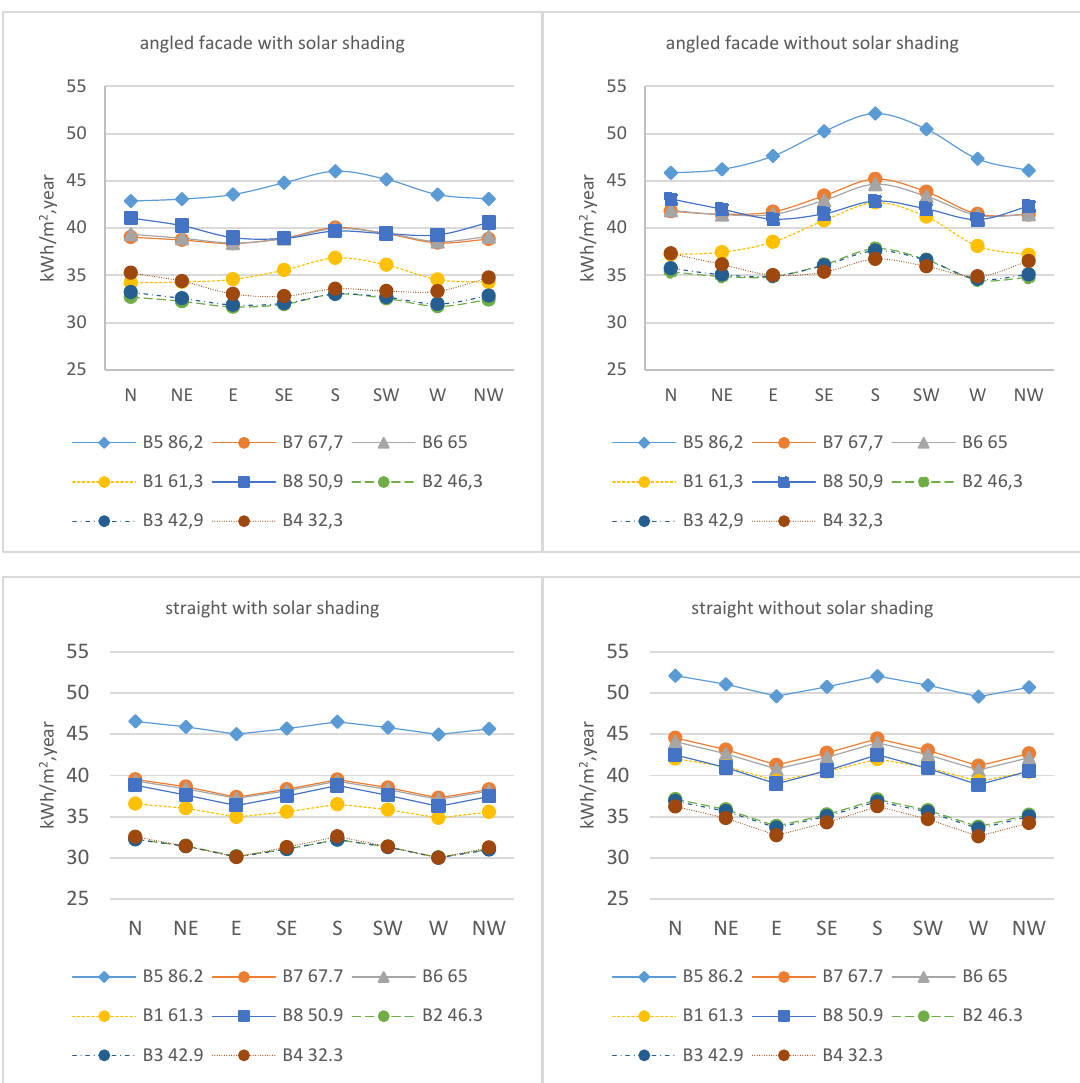
Figure 3. The total energy use for heating and cooling as a function of rotation of the office building in the city of Luleå. The eight different types of markers show results for each different amount of internal gain used in the simulations. The lines between the markers are only for ease of interpretation. The top left is with angled façade with solar shading, the top right is with angled facade without solar shading, the bottom left is with straight façade with solar shading and the bottom right is a straight façade without solar shading.